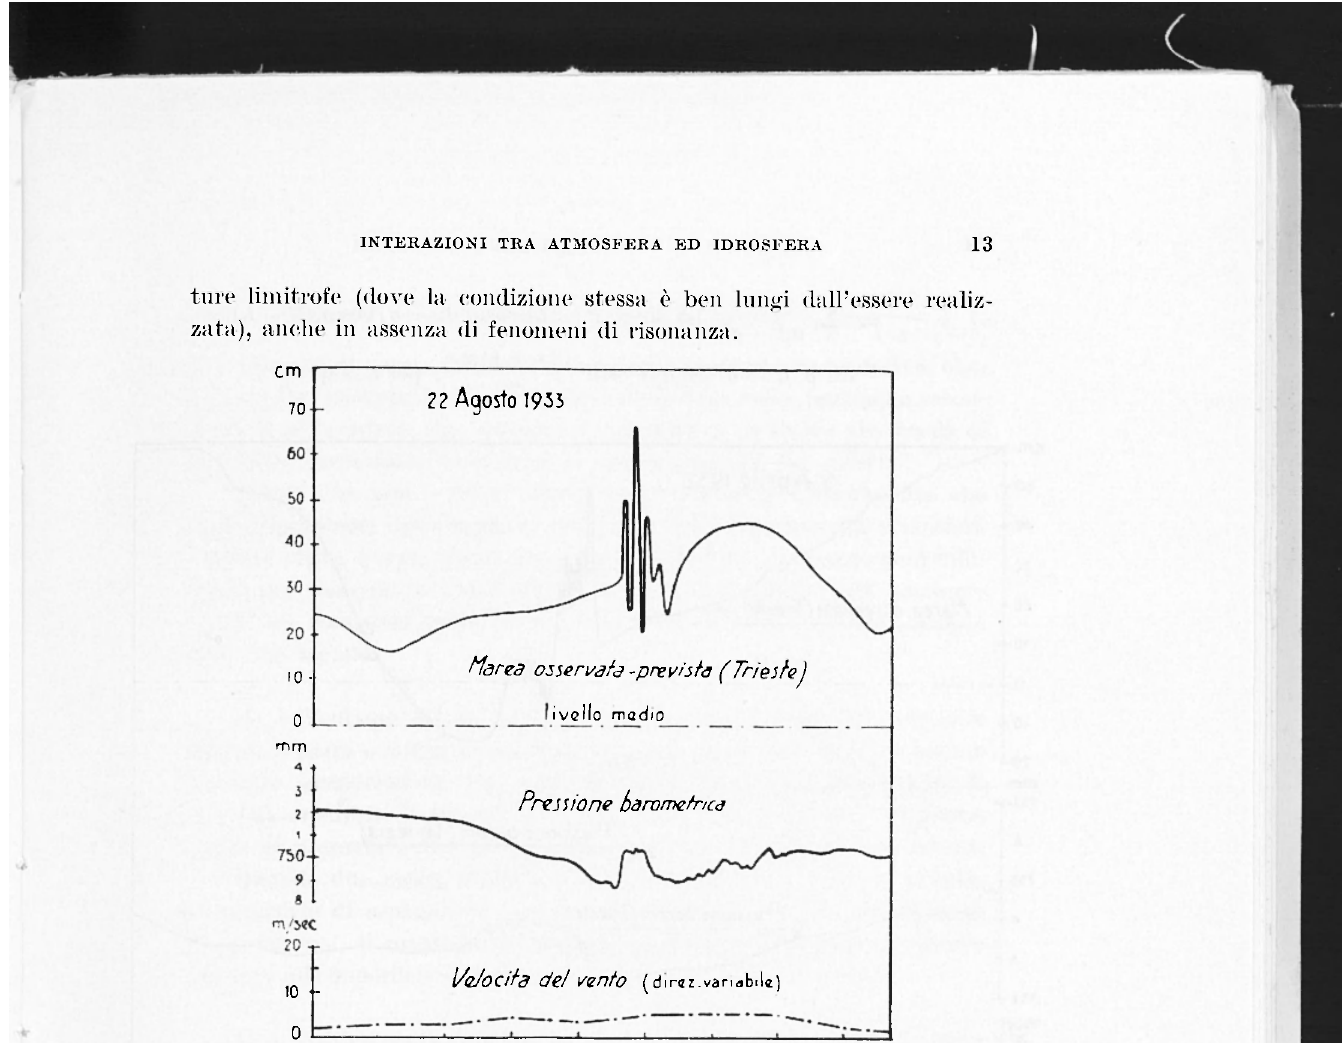
Fig. 3 - Movimento del mare a Trieste determinato dal transito di disturbi microbarici, propagantisi da Ovest ad Est con velocità paragonabile a quella delle onde libere del mare